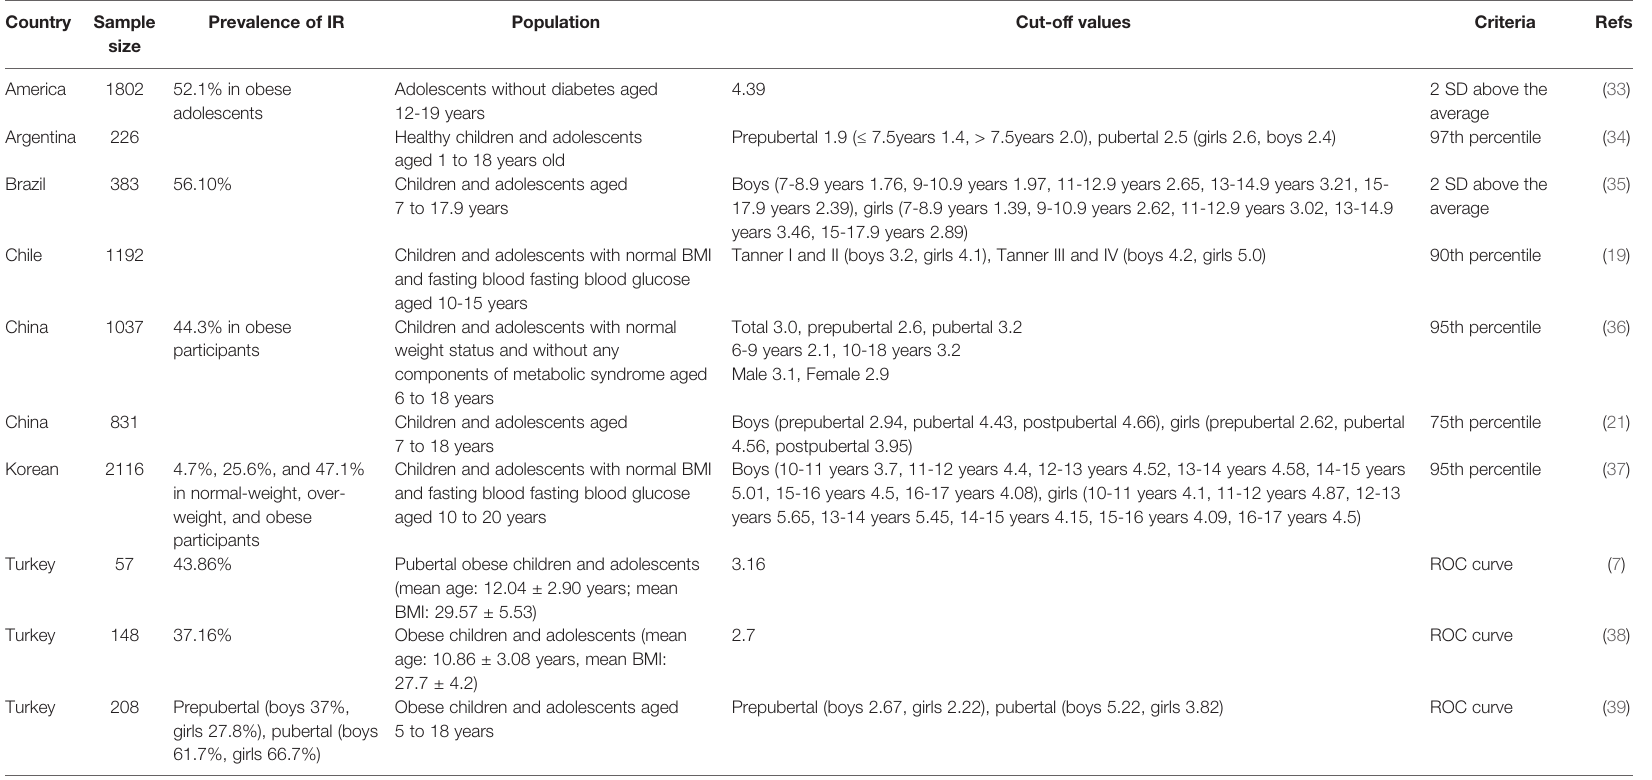
BMI, body mass index; IR, insulin resistance; ROC, receiver operating characteristic curve; SD, standard